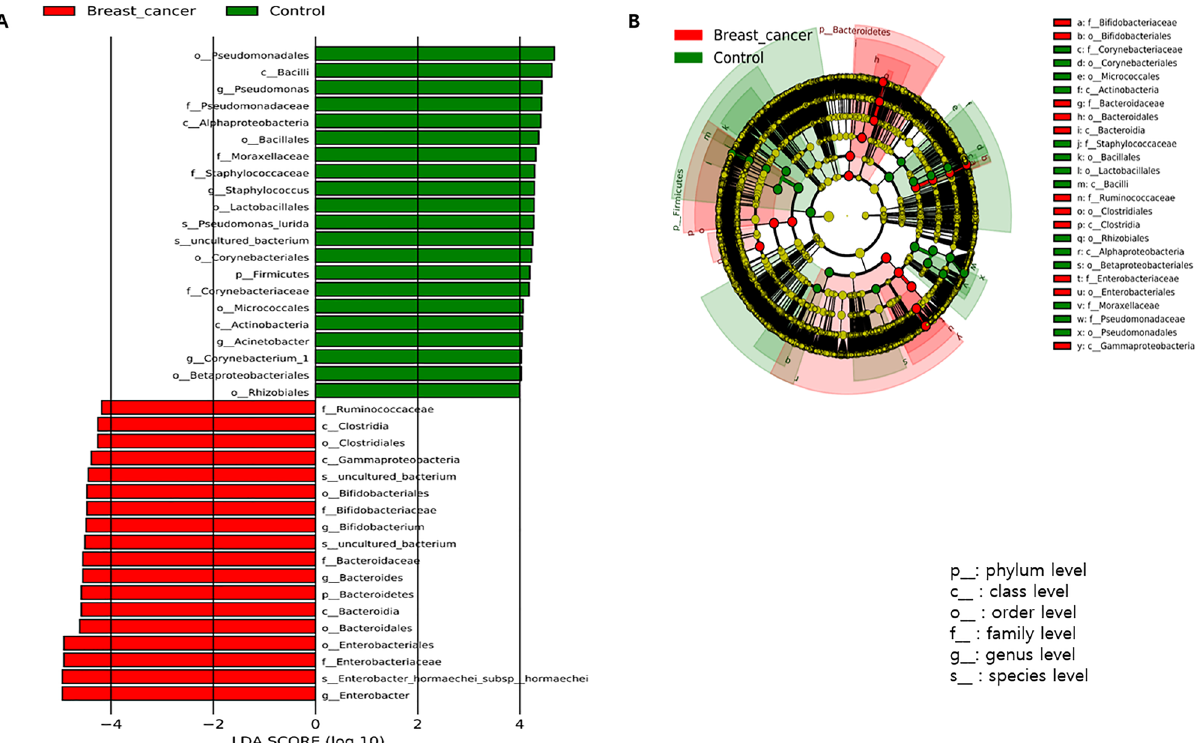
Figure 4. Significantly different taxa between breast cancer and healthy control based on the linear discriminant analysis (LDA) and effect size (LEfSe) analysis. ( A ) LDA score and ( B ) Cladogram.